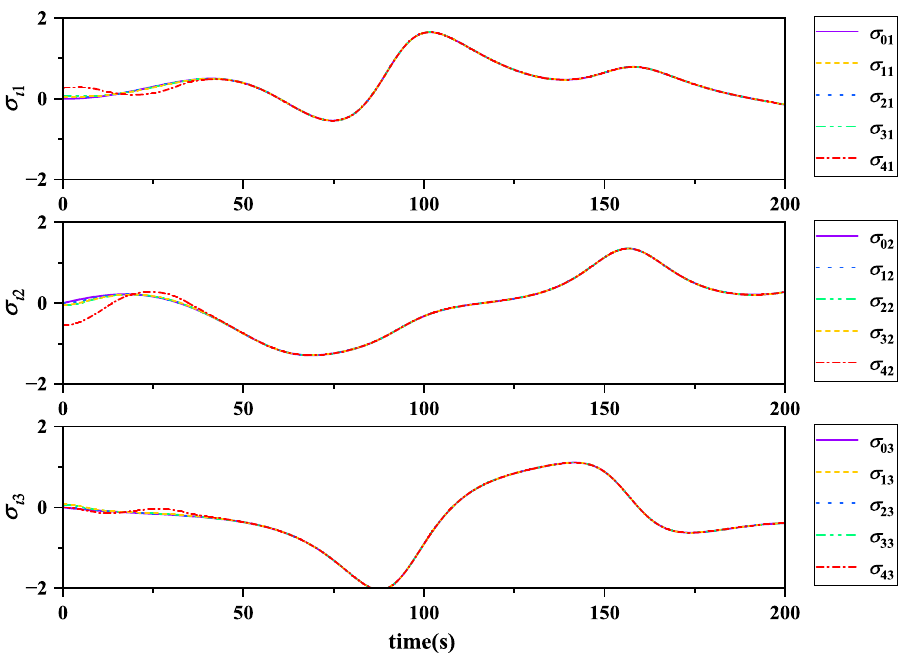
Figure 5. Attitude MRPs synchronization performance of four spacecraft. The parameters k = 0.2, k 1 = 10 and k 2 = 1.5 are designed to drive the sliding mode vector onto the sliding manifold and ensure that the state variable finally evolves into a neighborhood of the equilibrium point. The fractional-order sliding mode tuned by k 2 is utilized to accelerate the convergence of s i . The control torques are illustrated in Figure 6, in which the input saturation constraint u i , k ≤ 0.3 ( Nm ) is clearly seen. The output torque upper bound u i , k ,max reveals the control capacity of the actuator and determines the convergence rate to a large extent.